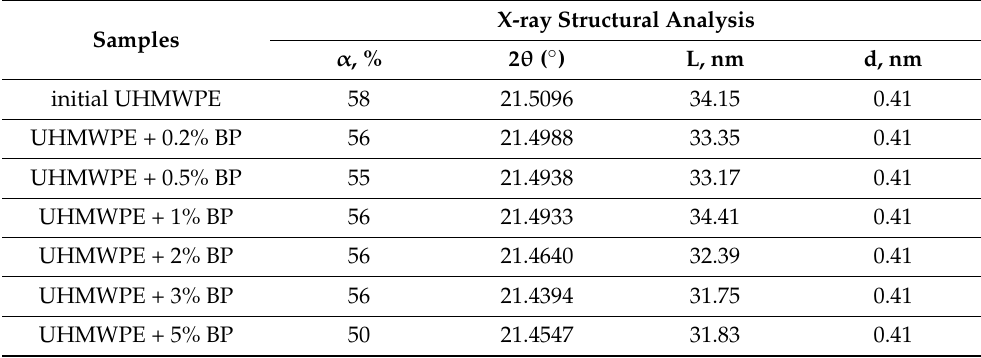
Figure 7. X-ray diffraction patterns of UHMWPE and PCM. Table 1 shows the results of XRD analysis of UHMWPE and UHMWPE/BP composites. Table 1. Results of X-ray structural analysis.